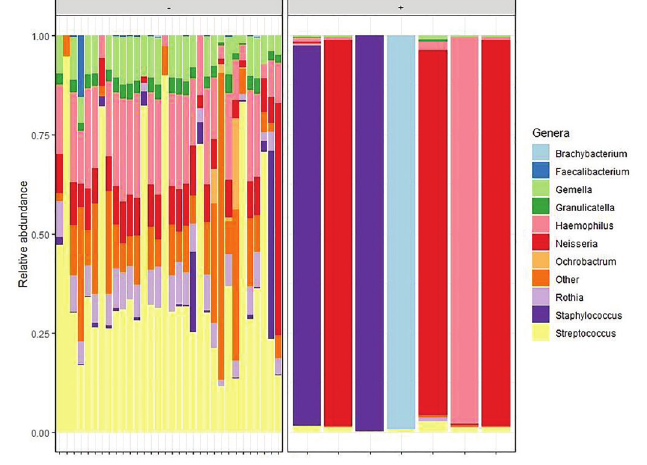
A clear separation of vaccinated and non-vaccinated groups is also shown using the Bray-Curtis and UniFrac methods (Figure 4).